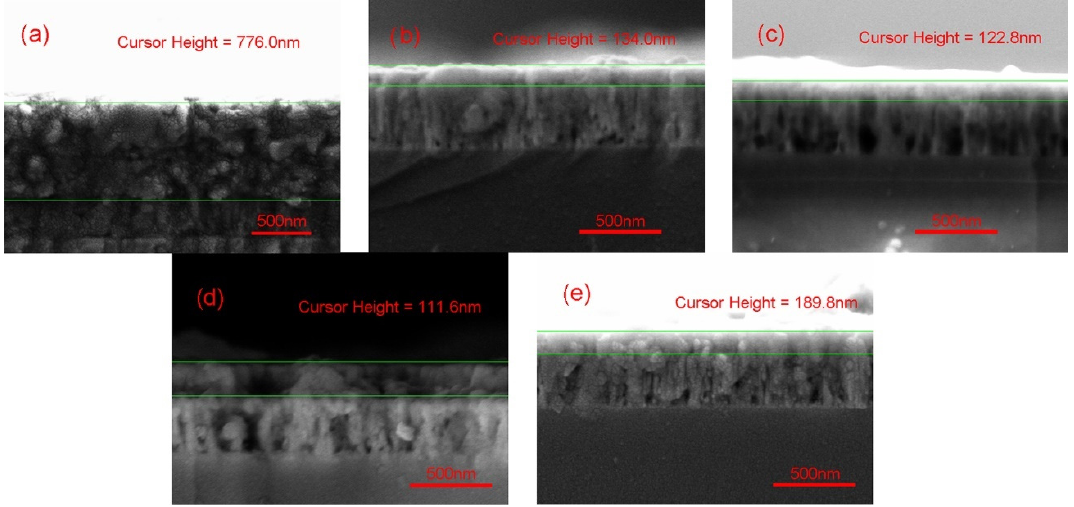
Figure 1. SEM side-view images of ZnO/TiO 2 films: ( a ) ZT1; ( b ) ZT2; ( c ) ZT3; ( d ) ZT4; ( e ) ZT5.